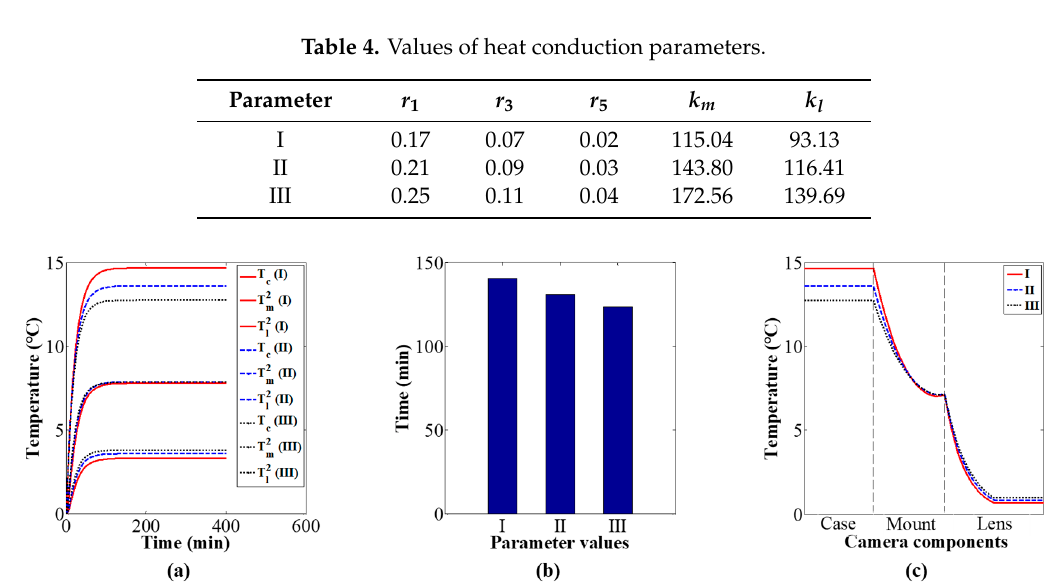
Figure 8. Effect of heat conduction parameters on camera component temperature variation and distribution: ( a ) components temperature variation, ( b ) thermal equilibrium time, and ( c ) distribution of equilibrium temperature.